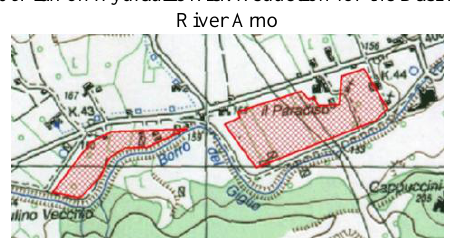
Figure 5. The same shape file superimposed to new IGM Map